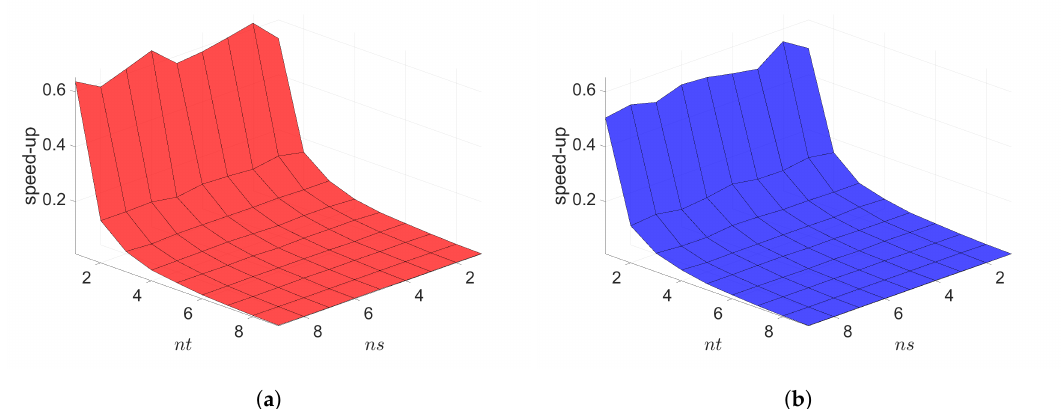
Figure 6. 2D linear diffusion equation. Online speed-ups vs. reduced dimensions. Both Galerkin and LSPG show similar speed-ups. ( a ): Online speed-ups vs. reduced dimensions for Galerkin projection, ( b ): Online speed-ups vs. reduced dimensions for LSPG projection.